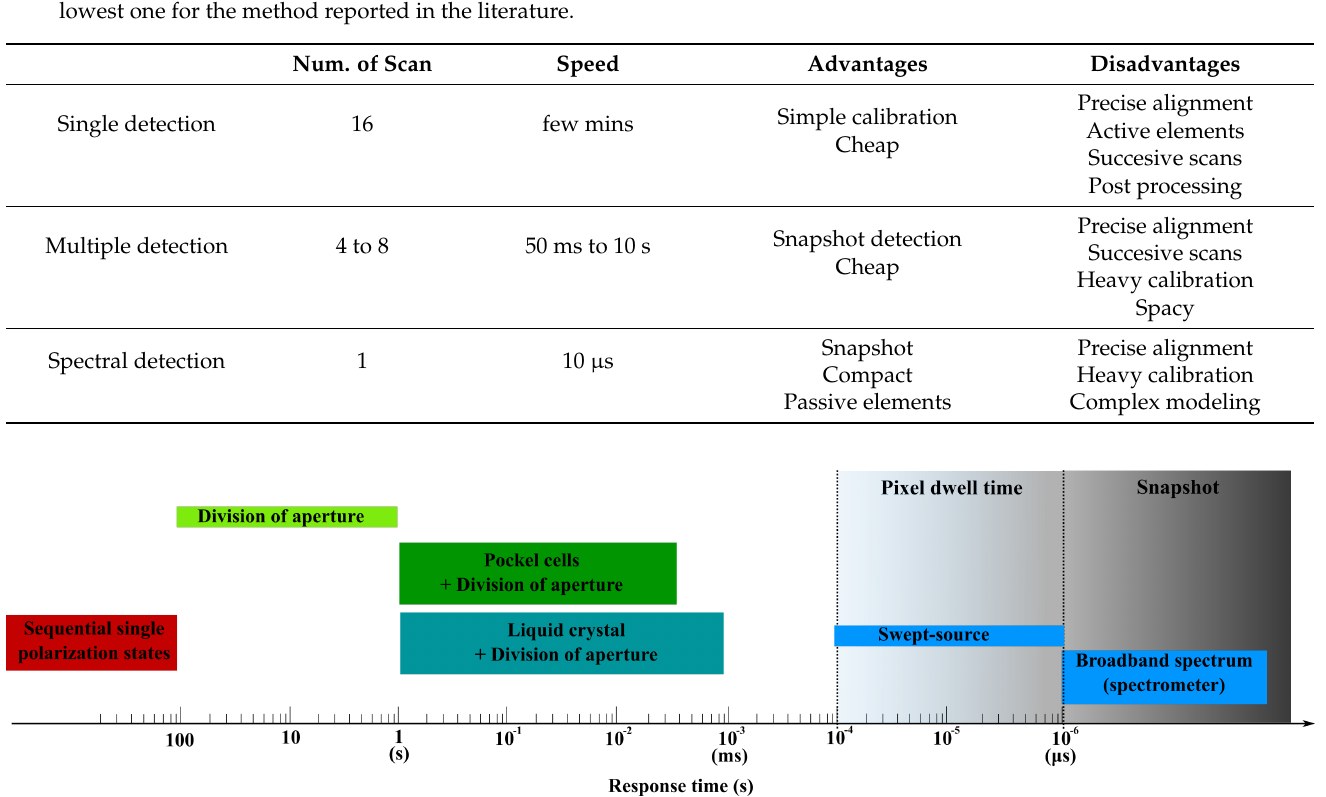
Figure 4. Comparative acquisition speed for measuring the full MM images using the sequential/spectral approaches according to the optical SLM architecture presented in the